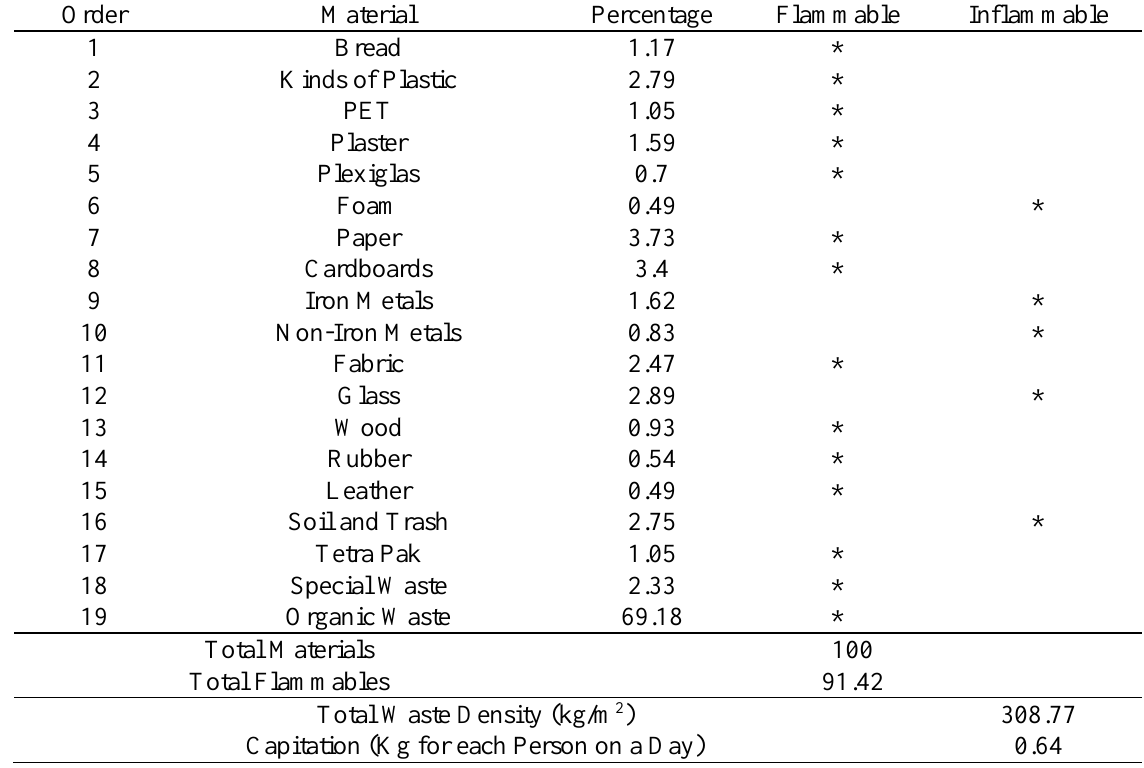
Table 4 . The Average Analysis of Municipal Waste in the Studied Cities